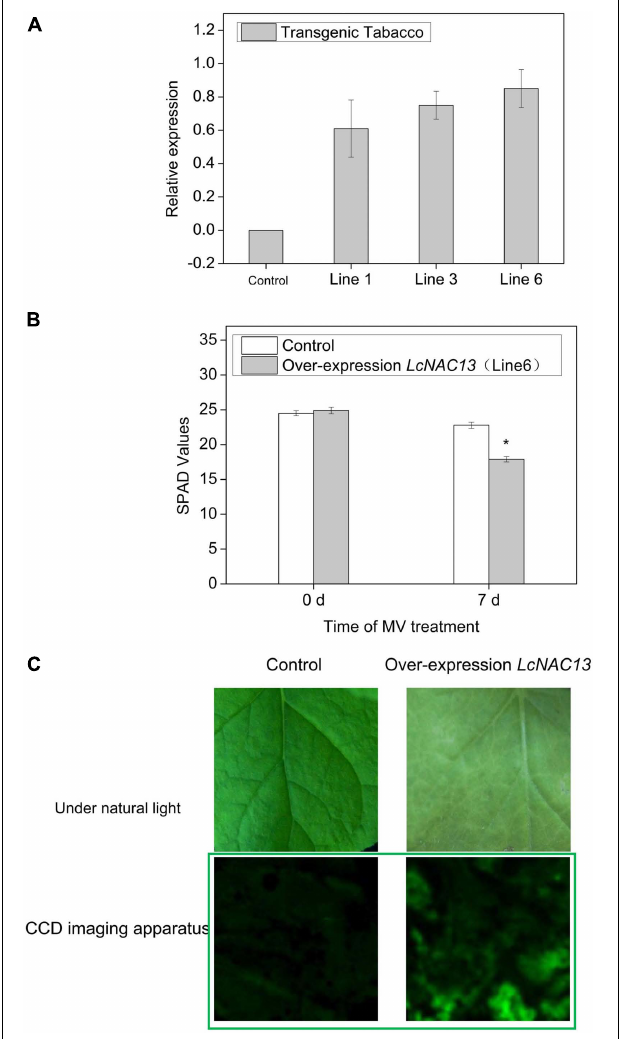
FIGURE 6 | Overexpression of LcNAC13 promotes ROS-dependent senescence in tobacco. (A) Relative expression of LcNAC13 in the transgenic and wild-type plants. (B) SPAD values in leaves of the transgenic and wild-type plants after MV treatment. (C) Phenotype of the LcNAC13 transgenic tobacco leaves after 10 days of MV treatment. Vertical bars represent SE ( n = 3); an asterisk indicates a significant difference according to Student’s t -test ( P ≤ 0.05). The green box indicates imaging under a deep-cooled CCD